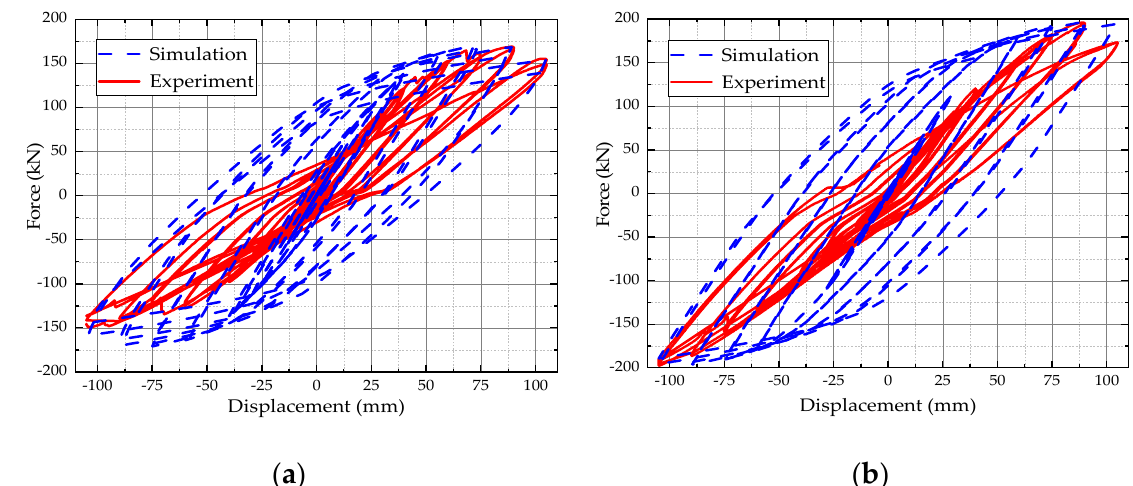
Figure 22. Comparison of ( a ) FW-1 and ( b ) FW-2 experiment and simulation hysteresis curve.